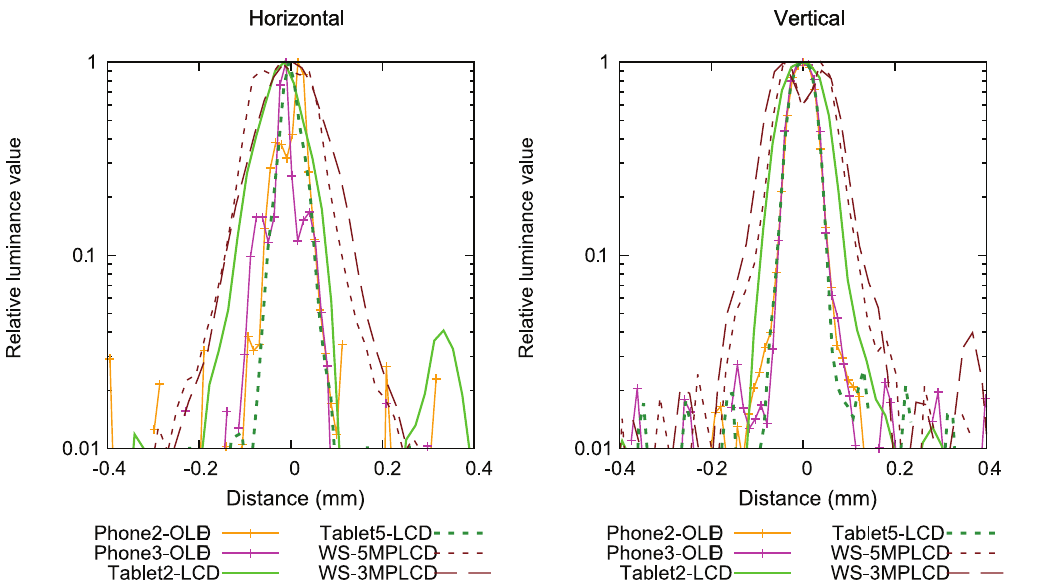
Figure 4. Line spread functions for the devices tested in this study. The relative luminance profiles on a 1-pixel line are shown on logarithmic scale.